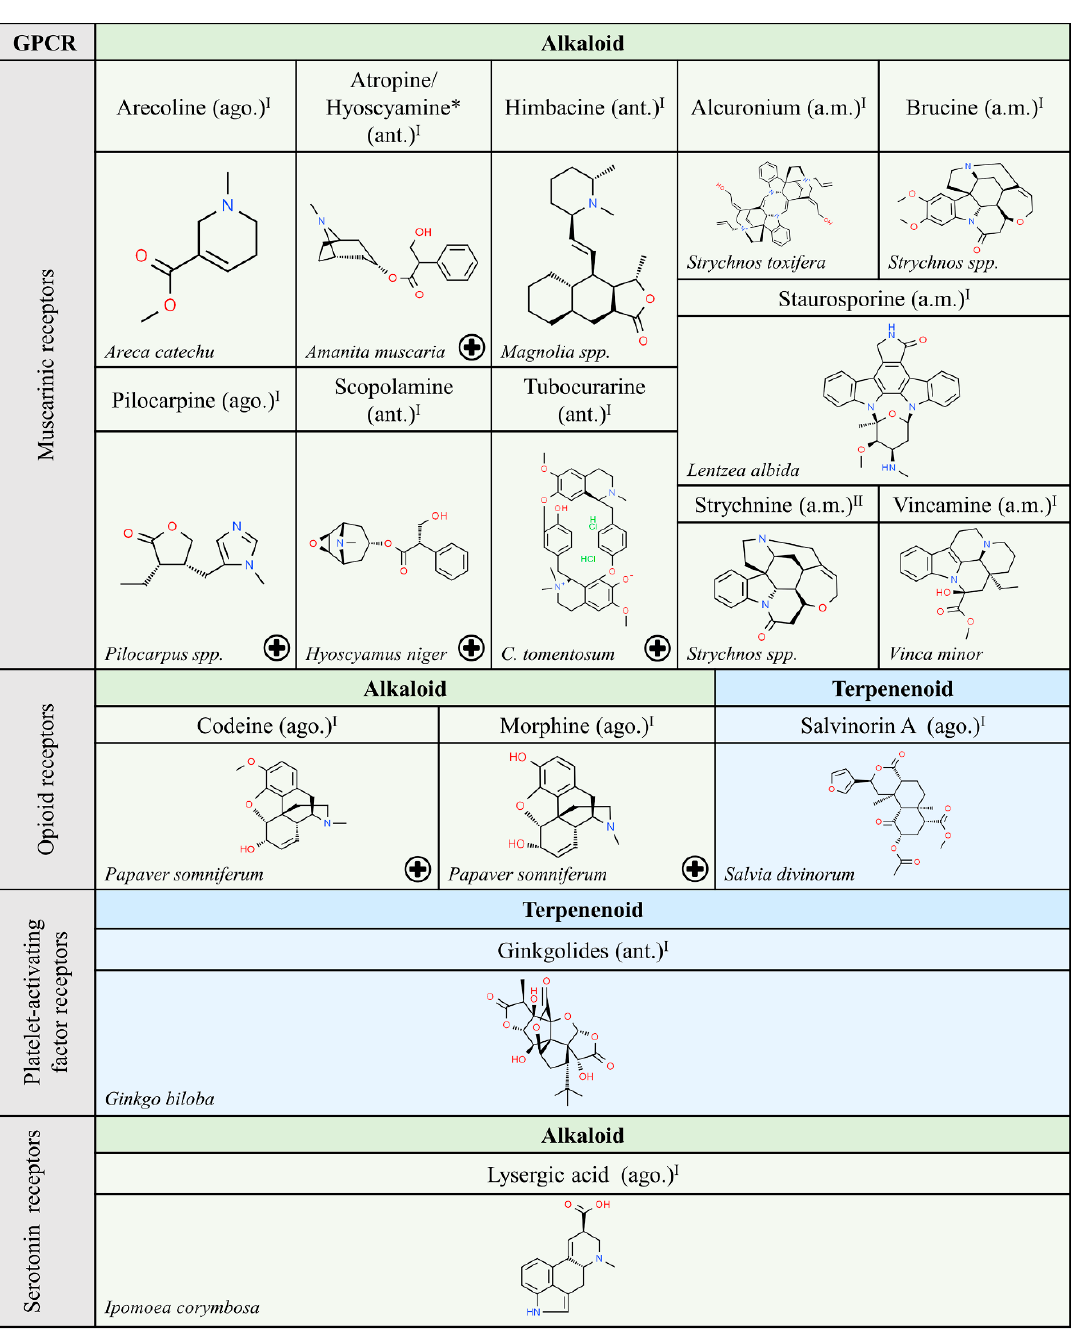
Figure 4. Natural ligands of GPCRs from plants (part. 2). Each chemical class is highlighted with different colors. The chemical structures were found on ChemSpider website. Legend: the plus symbol means that the compound is approved by the Food and Drug Administration. The asterisk (*) means that the compounds are isomers. Ago.: agonist; ant.: antagonist; a.m.: allosteric modulator. Superscript: (I) [1]; (II) [33].